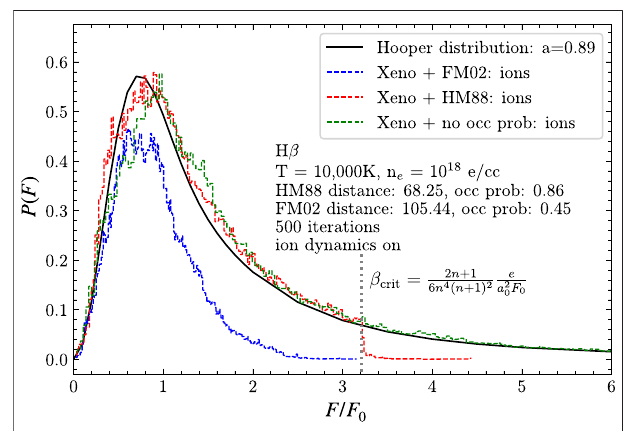
OP prescriptions. For HM88, we see that our prescription for reversing the radial velocitiesofnearbyapproachingionsleadstoasharpcutoffat F / F 0 ≈ 3.2.Wenote that the HM88 and FM02 distributions have been normalized to their OP values, 0.86 and 0.45, respectively. Taken from Cho et al.